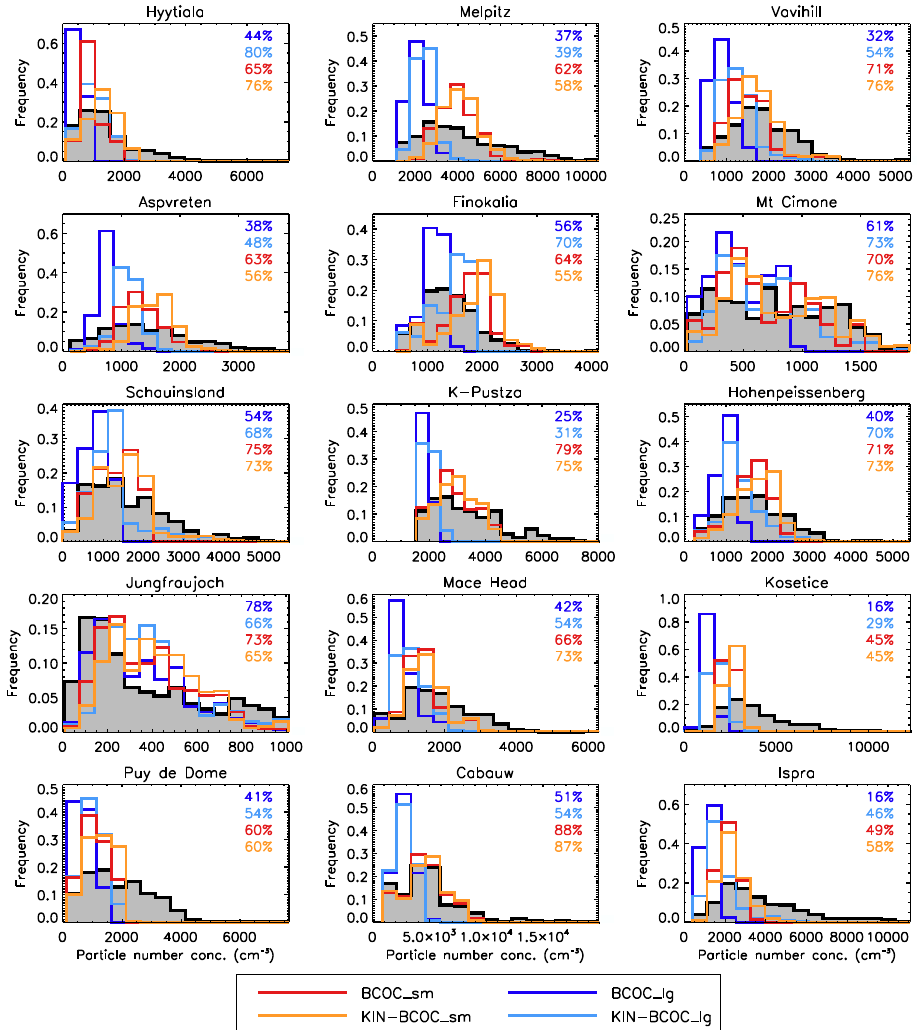
Fig. 7. Normalised histograms of the frequency distribution of hourly-mean simulated (colour) and observed (black) number concentrations of particles with D p > 50nm ( N 50 ) for May 2008 at each ground site. Bin size depends on the maximum N 50 observed at each site; number concentrations are divided into 15 equally spaced bins. The percentage overlap between the modelled and observed frequency distributions is given in the top right hand corner. Please note that the colours representing the model experiments in this figure (chosen to be easily distinguishable from each other) differ from the previous and following figures. Model experiments are described in Table